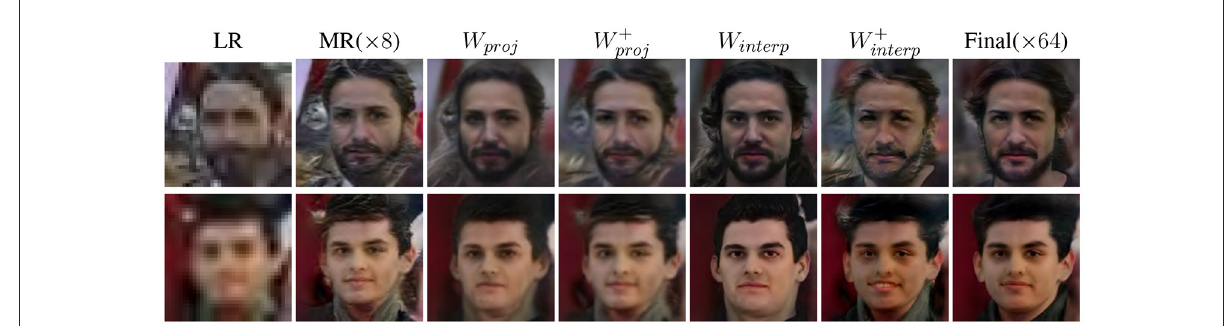
FIGURE5 Comparison of visual quality among different stages of our two-step FSR method. From left to right : low resolution 16 × 16 input image, The mid-resolution 128 × 128 image. W proj and W + proj : The projection of the Mid-resolution image into the W and W + spaces of StyleGan (Karras et al., 2019). W interp and W + interp indicate the interpolated vectors in the W and W + spaces of StyleGan (Karras et al., 2019) using Equation (9). Final results is obtained by combining the interpolated vectors using Equation (10).